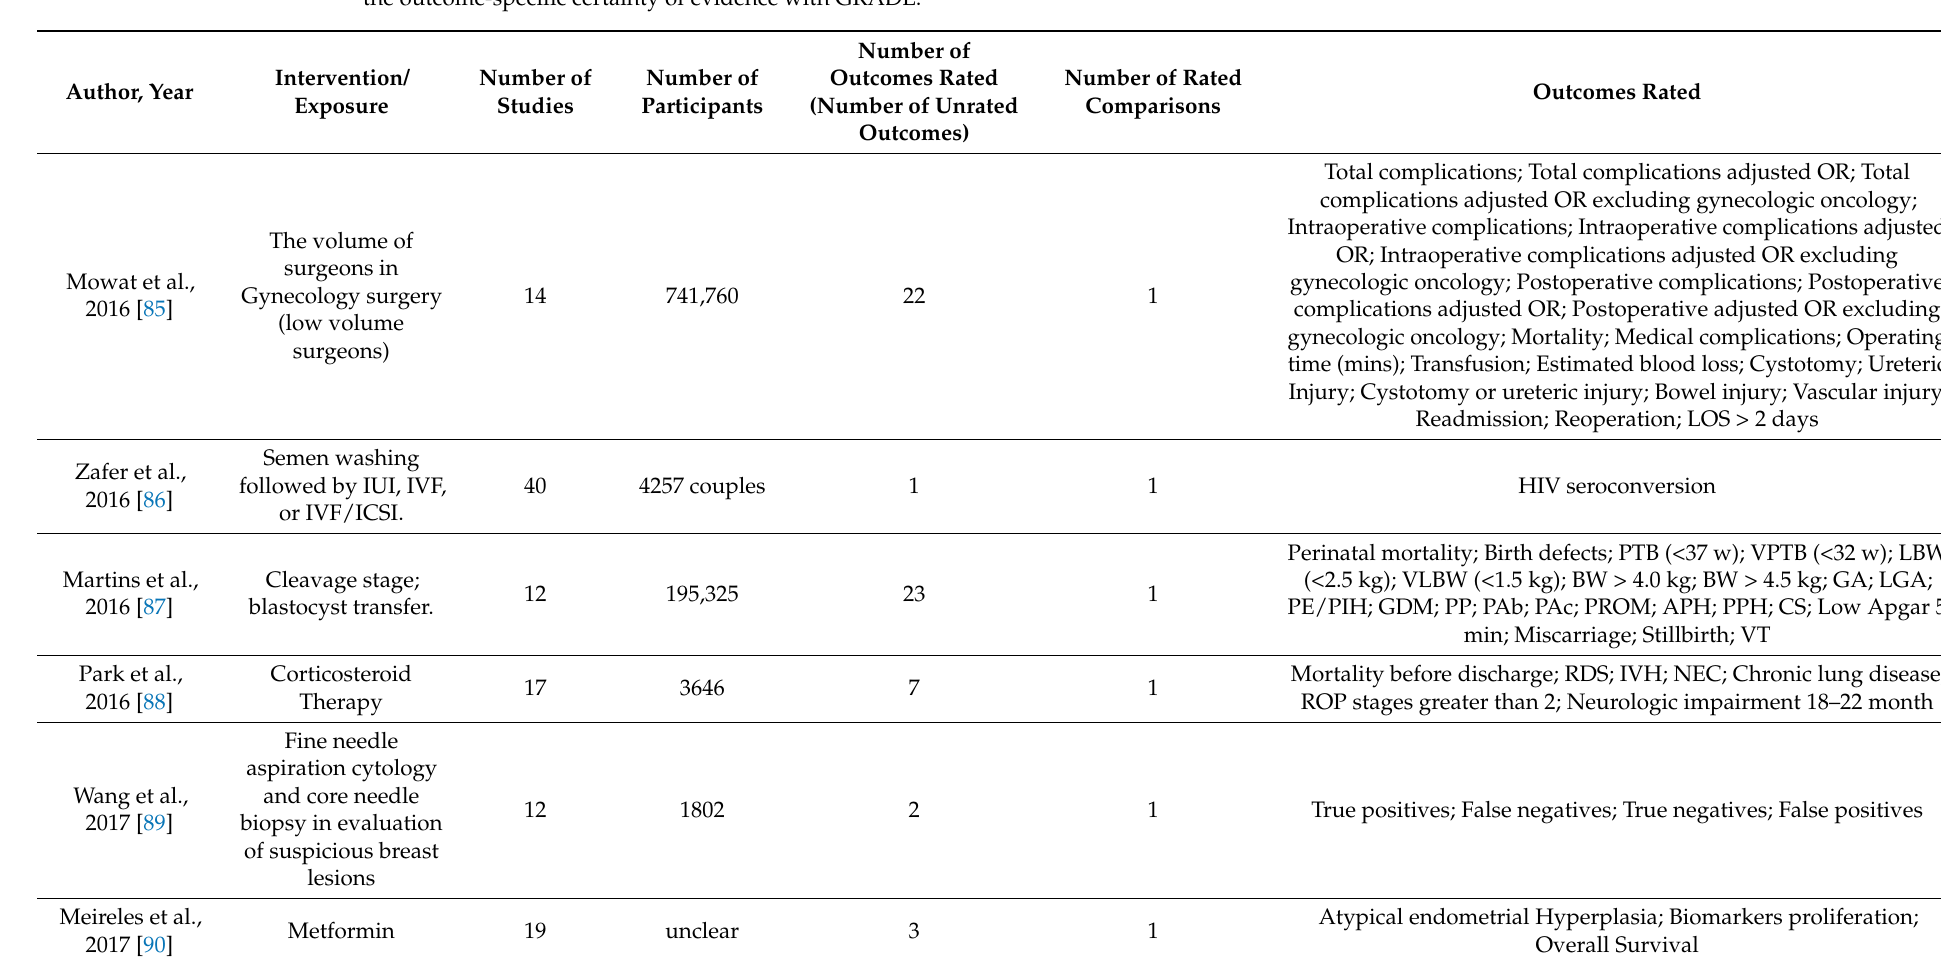
Table 3. Summary of the study characteristics and the number and type of (un)rated outcomes of systematic reviews of nonrandomized studies ( n = 18) that rated the outcome-specific certainty of evidence with